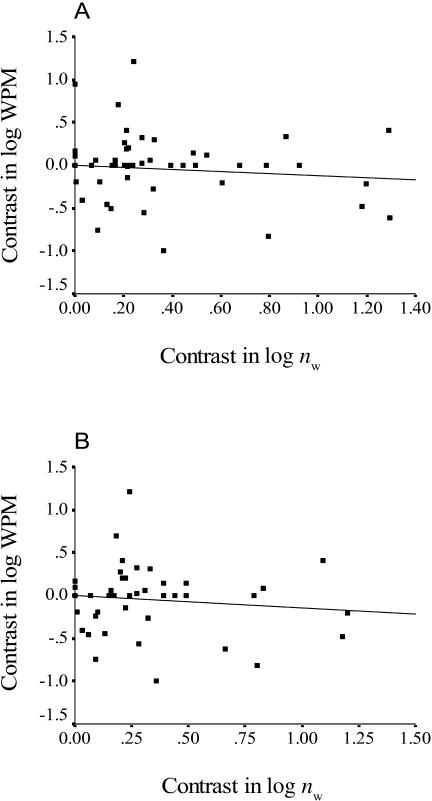
Variation in Worker Reproduction with Colony SizeAxes show standardized independent contrasts in the proportion of worker-produced males (log10WPM) and in colony size (log10
n
w). (A) includes all species; (B) includes only species in which relatedness predicts worker-produced males (i.e., r
diff is positive). Lines of regression are forced through the origin.